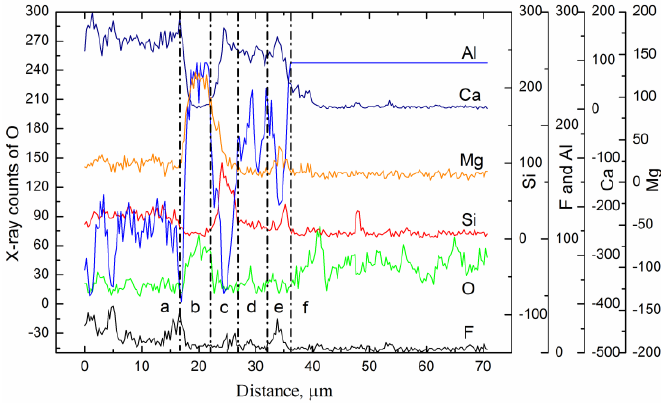
Figure 4. Line-scanning image of boundary layer of alumina particle and solid slag in slag S1.